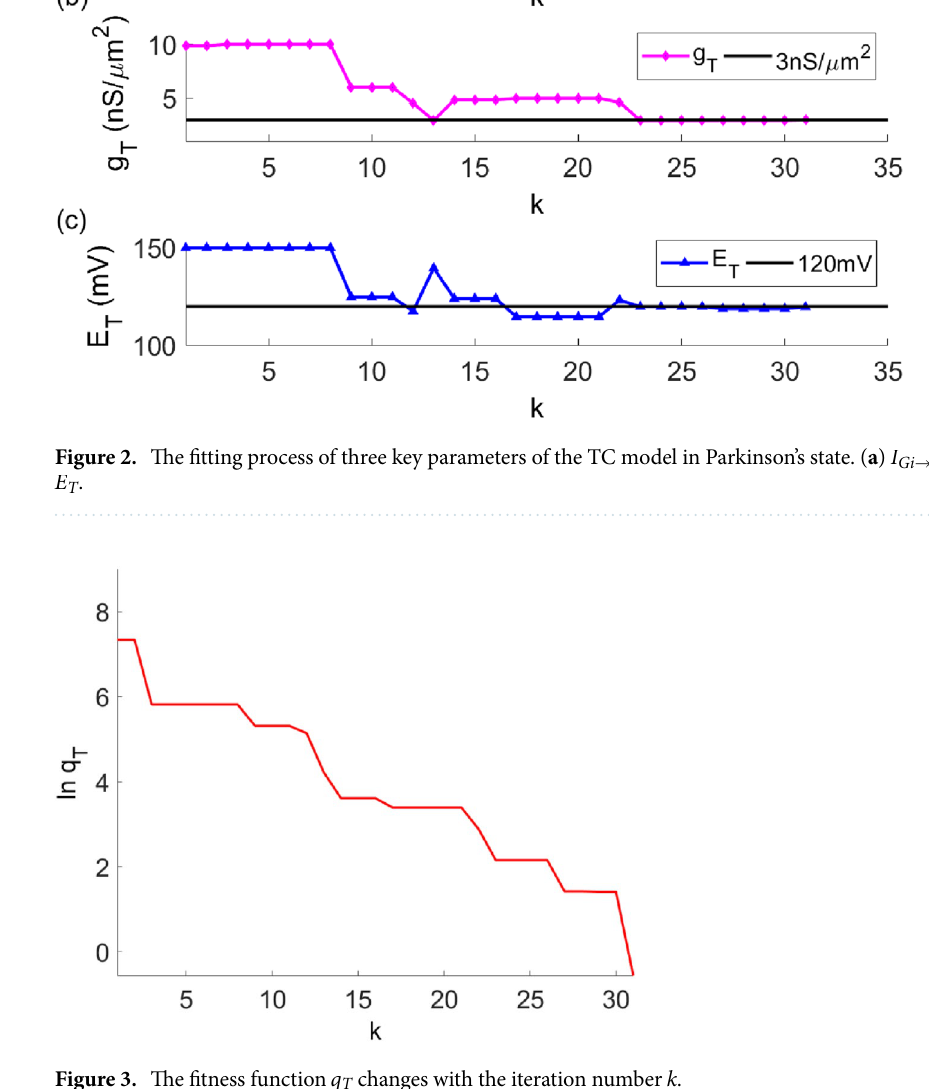
Figure 3. The fitness function q T changes with the iteration number k